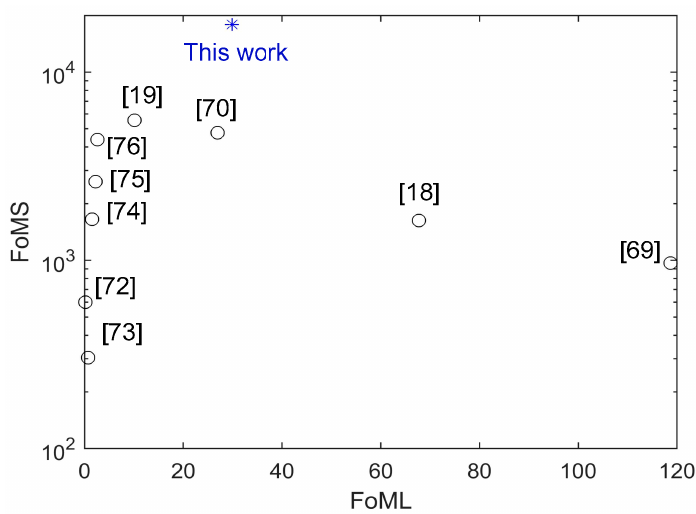
Figure 13. Performance comparison.